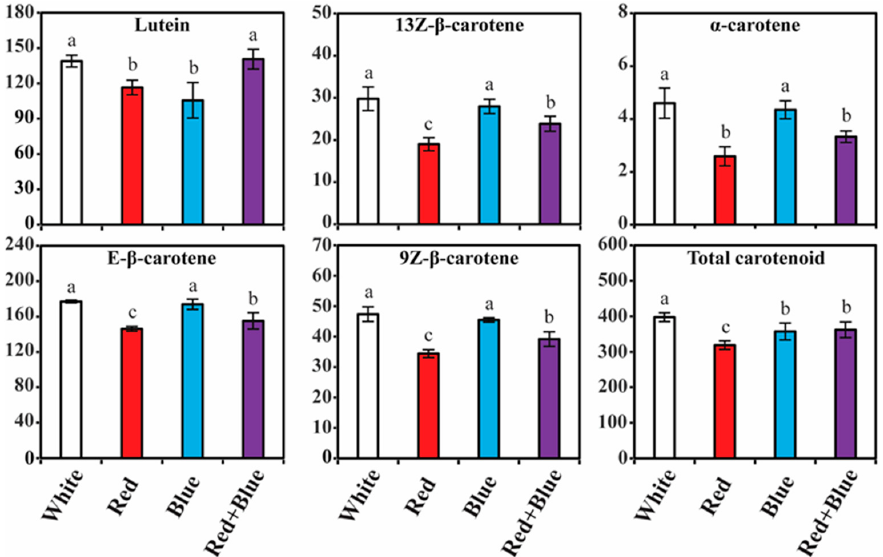
Figure 5. Carotenoid contents (µg/g DW) in kohlrabi sprouts irradiated with di ff erent LED lights. Samples were collected after 10 days of growth. Mean values marked with di ff erent alphabetical le tt ers were signi fi cantly di ff erent ( p < 0.05, ANOVA, DMRT).